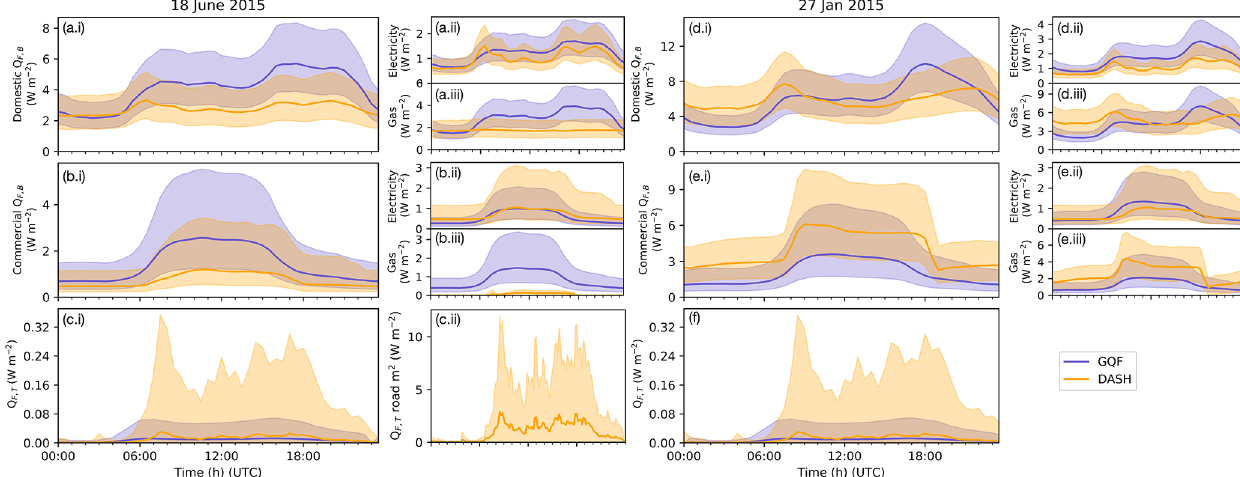
Figure 8. Analysis of Q F (R6, Table 6) median (line) and IQR (shading) in 2015 for (a, b, c) 18 June and (d, e, f) 27 January – showing total Q F, B for (a.i, d.i) domestic and (b.i, e.i) commercial, with the following: (a.ii, d.ii) domestic electricity (GQF) or appliance power demand (DASH); (a.iii, d.iii) domestic gas (GQF) or heating + cooling + hot water demand (DASH); (b.ii, e.ii) commercial electricity (GQF) or appliance power demand (DASH); (b.iii, e.iii) commercial gas (GQF) or heating + cooling + hot water demand (DASH); and (c.i, f) Q F,